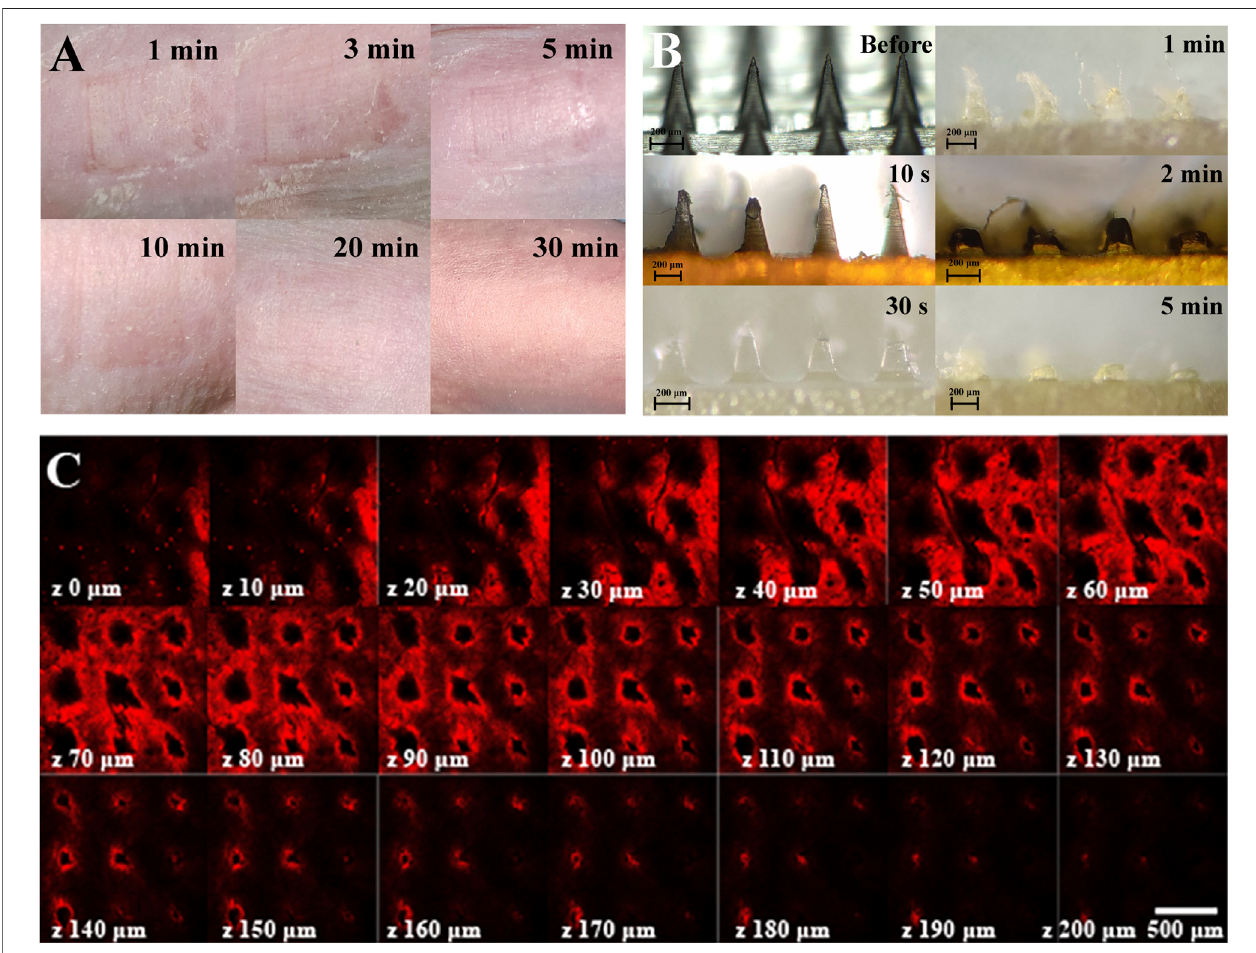
FIGURE 3 | Skin puncture test and drug release characterization of an MN. (A) Recovery of the skin puncture site in vivo. (B) Dissolved state of the MN in pig skin punctured by the MN at different time points. (C) Laser confocal image of drug penetration depth of fl uorescein-loaded, MN-pierced pig skin, the scale is 500 μ m.